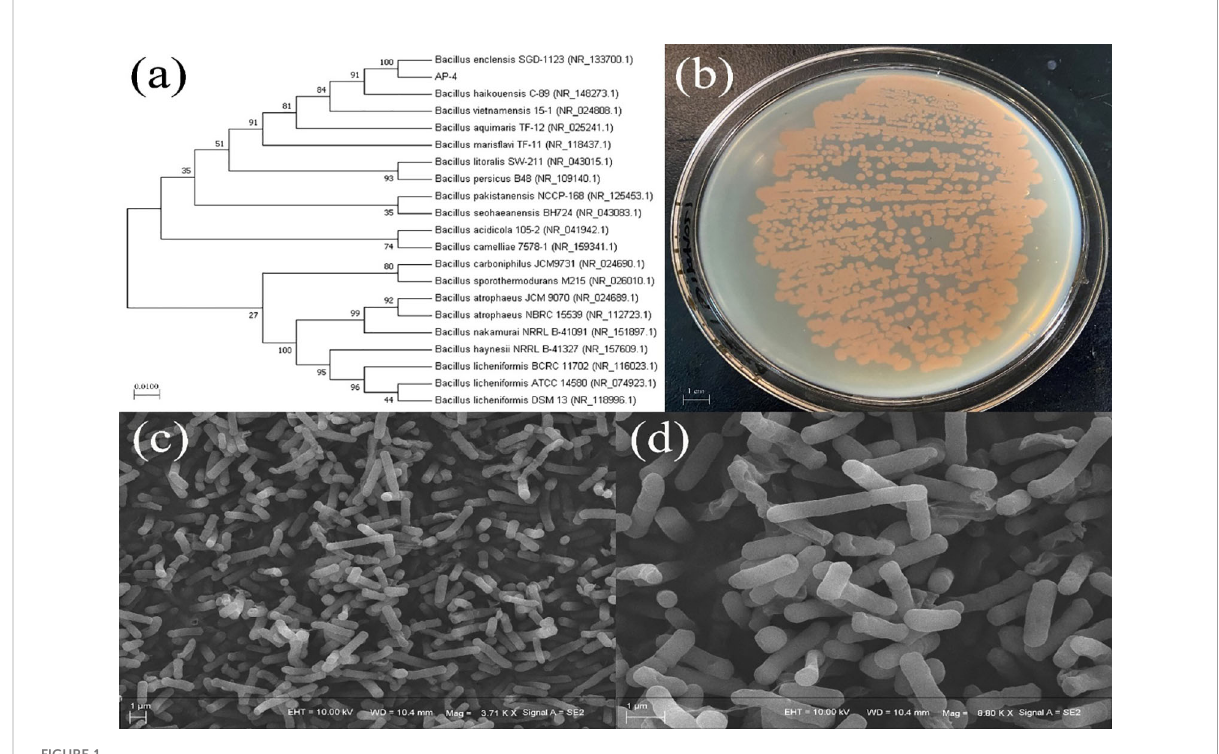
FIGURE 1 Phylogenetic tree of strain AP-4 and the related twenty strains by Neighbor-joining method (A) Image of strain AP-4 on LB solid medium (B) SEM image magni fi ed 3710 times (C) SEM image magni fi ed 8800 times (D)